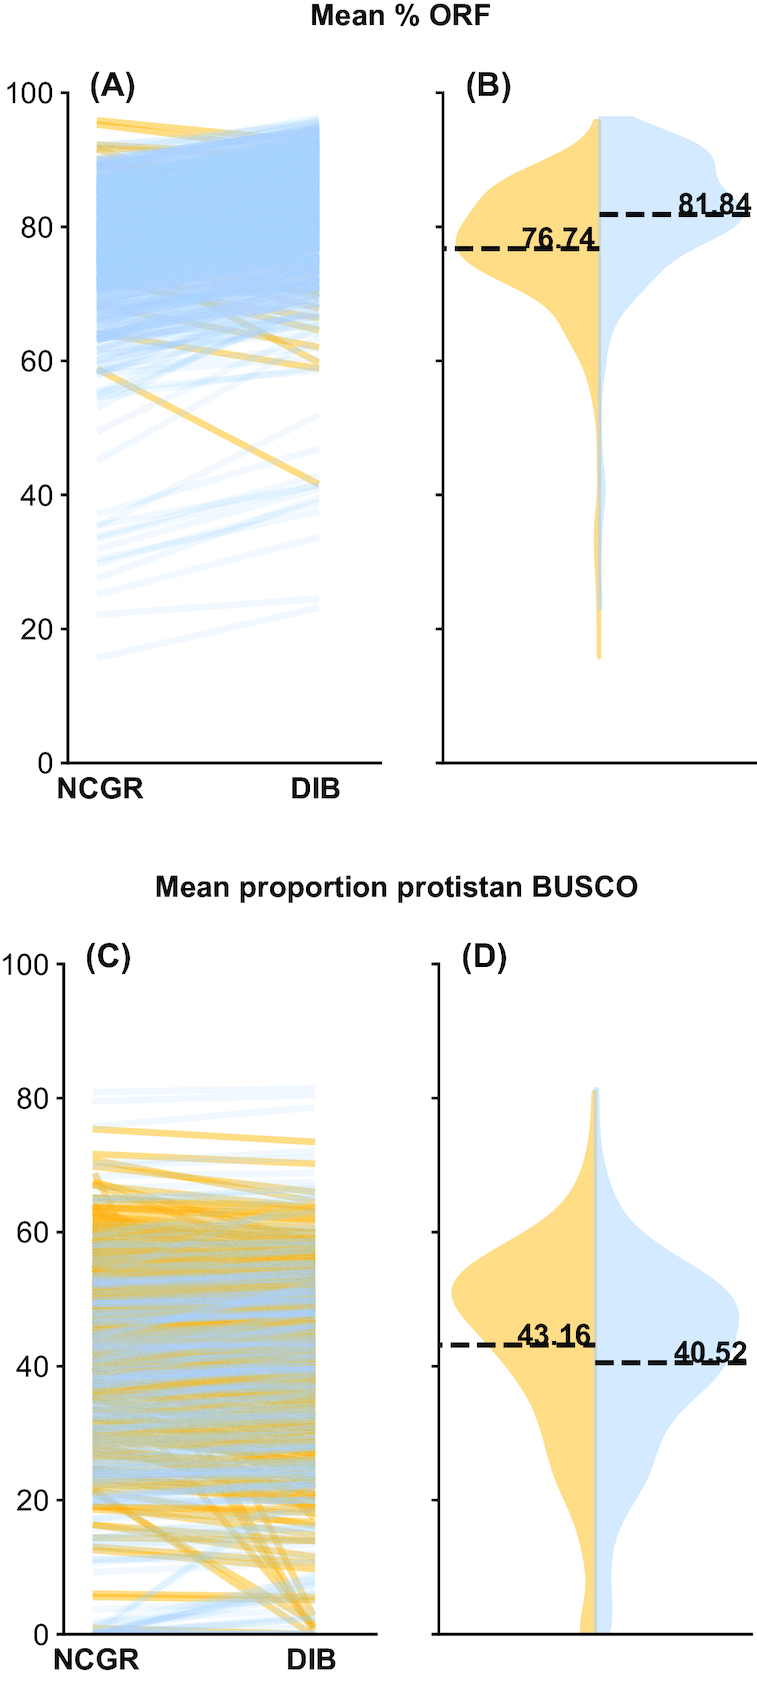
The percentage of contigs with a predicted ORF (A, B) and the percentage of complete protistan universal single-copy orthologs (BUSCO) recovered in each assembly (C, D). In blue (right side B, D) are the DIB re-assemblies and in yellow (left side of B, D) are the original ‘nt' assemblies from NCGR. Slope graphs (A,C) compare values between the DIB and the NCGR ‘nt' assemblies. Yellow lines represent negative slope values where NCGR was higher than DIB, and blue lines represent positive slope values where DIB was higher than NCGR.